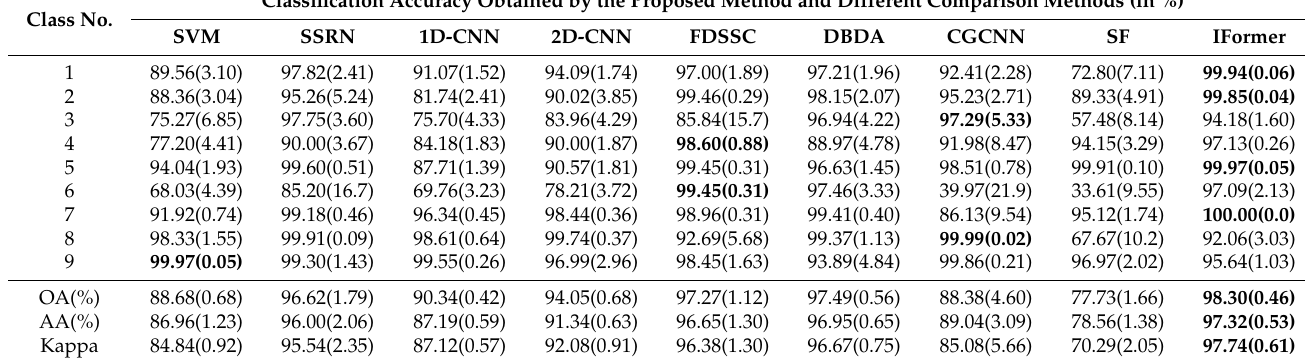
Table 6. Accuracy comparison of different methods on UP dataset.